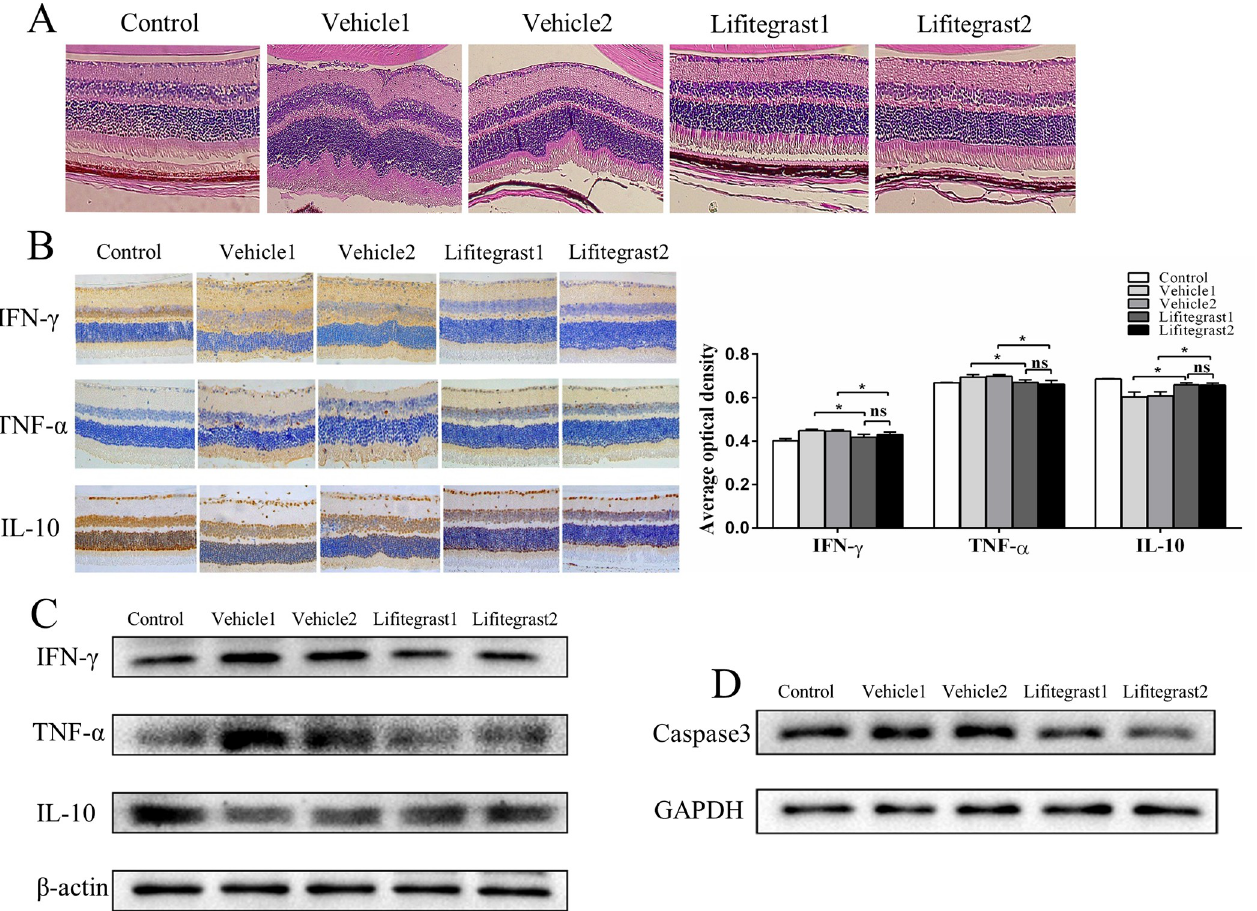
Fig 7. Topical lifitegrast administration reduced ocular inflammation. (A) Histology of the eye at Day 30 after infection in the OT murine model treated with vehicle or lifitegrast. Hematoxylin and eosin; 400 × . (B) Representative experimental retinas stained for IFN- γ , TNF- α and IL-10 from vehicle or lifitegrast-treated murine OT. Immunohistochemistry showed that the production of pro-inflammatory cytokines (IFN- γ , TNF- α ) but not anti-inflammatory cytokines (IL-10) was significantly inhibited by lifitegrast treatment. 400 × . Quantification of IFN- γ , TNF- α and IL-10 expression levels in retinas by the software Image J. ns, not significant; � p < 0.05. (C) Western blot analysis showed that IFN- γ and TNF- α were decreased, while IL-10 was increased in infected eyes after lifitegrast treatment. β -actin was used as an internal control. (D)Western blot analysis showed that caspase-3 were decreased in infected eyes after lifitegrast treatment. GAPDH was used as an internal